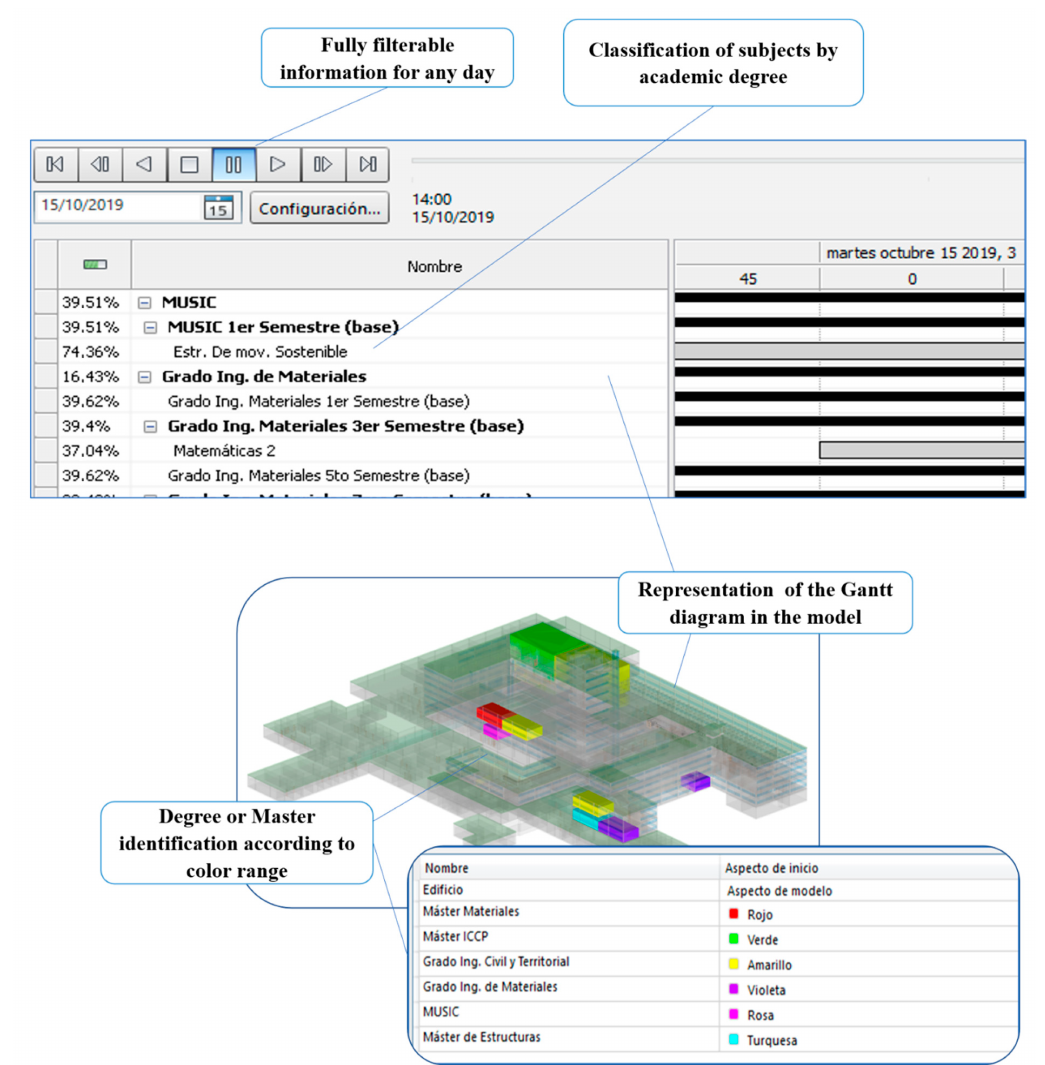
Figure 12. BIM educational data